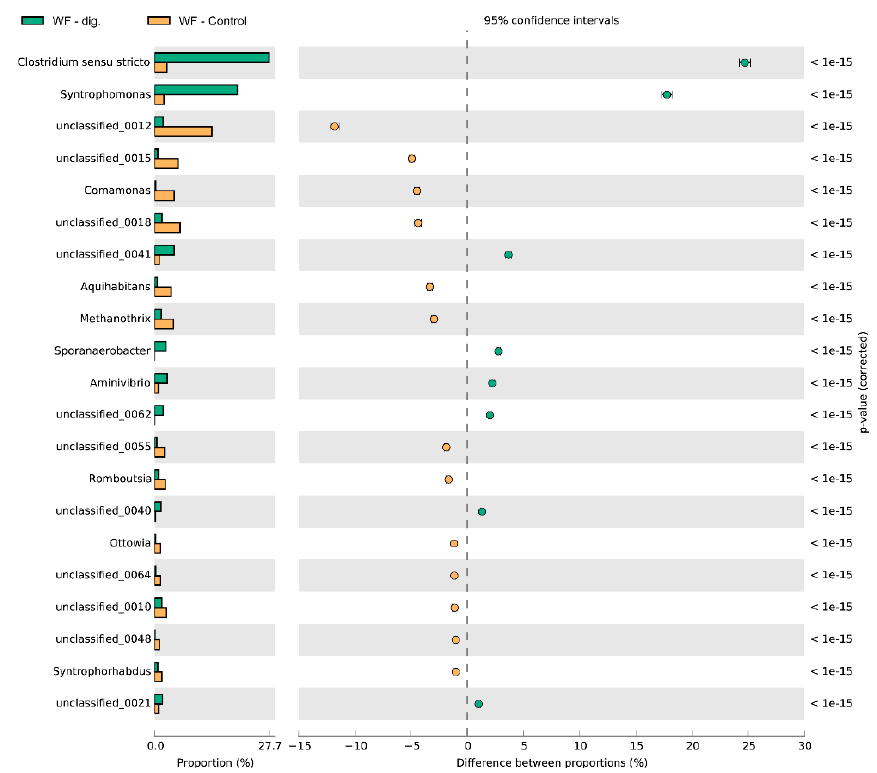
Figure 6. Comparison of bacteria genus composition between WF + DEP and WF-control variants.